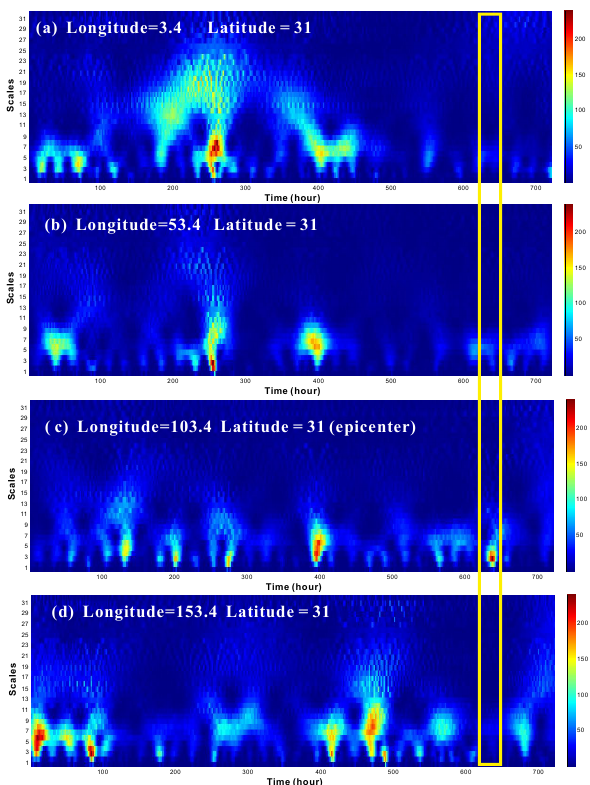
Figure 3. The analytic wavelet energy density spectrum of DTEC time series from 13 April to 12 May, 2008 right over the locations: (a) latitude = 31° N, longitude = 3.4° E; (b) latitude = 31° N, longitude = 53.4° E; (c) latitude = 31° N, longitude = 103.4° E (epicenter); (d) latitude = 31° N, longitude = 153.4° E.